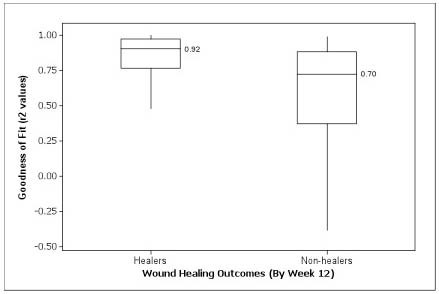
Boxplot (with medians) of goodness-of-fit statistics (r2) between VLU patients who healed and did not heal by Week 12.